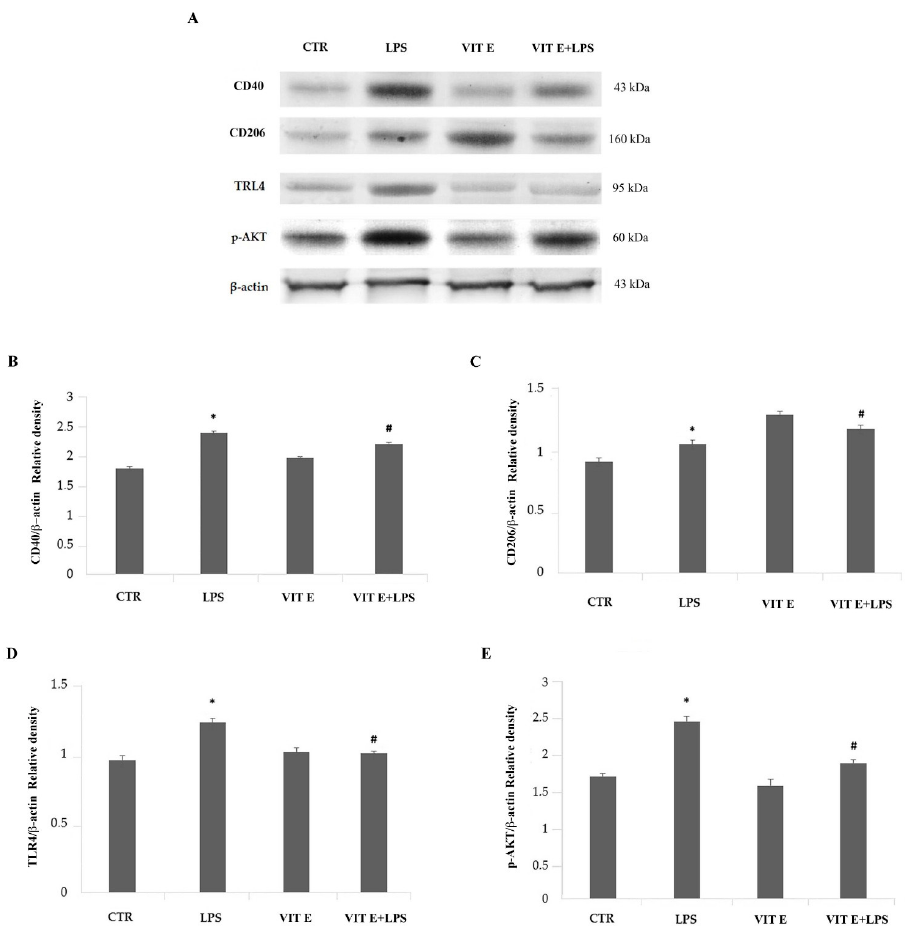
Figure 5. Evaluation of CD40, CD206, TLR4, and p-AKT expression following administration of vitamin E with or without LPS. Western blotting detection ( A ) and densitometric analysis of the expression of the pro-inflammatory CD40 ( B ), anti-inflammatory CD206 ( C ), TLR4 ( D ), and p-AKT ( E ) in control cells (CTR), BV2 cells treated with vitamin E (VIT E), BV2 cells treated with LPS (LPS), and BV2 cells treated with vitamin E + LPS (VIT E + LPS). Protein expression values are expressed in arbitrary units after normalization against β -actin. Data are presented as means ± SDs (* p < 0.05 vs. CTR; # p < 0.05 vs. LPS).